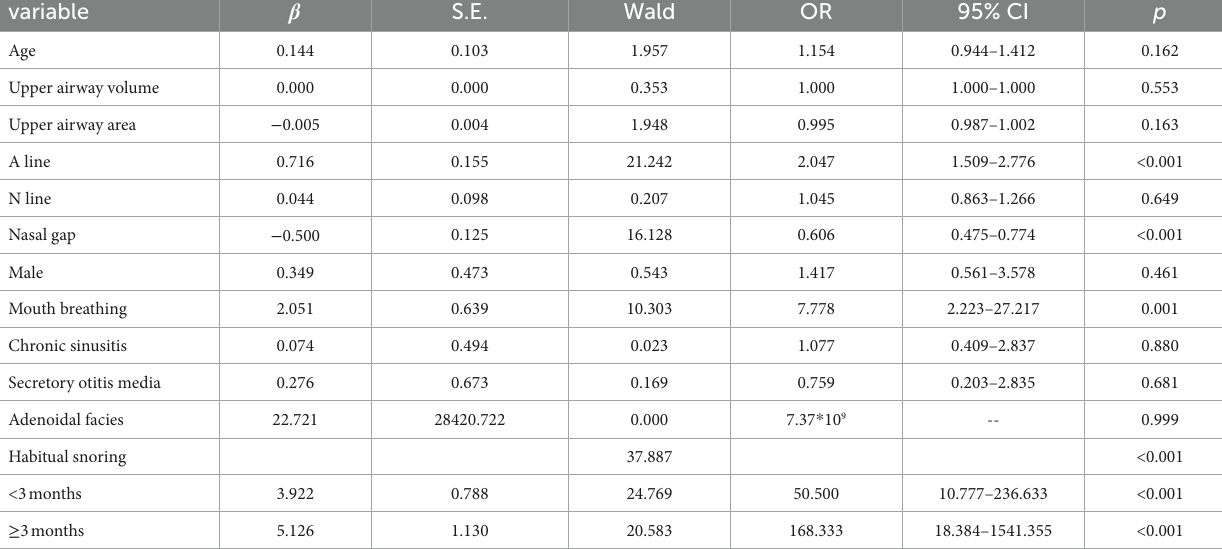
TABLE 2 Univariate logistic regression analysis of the relationship between clinical information and OSA ( n = 130).